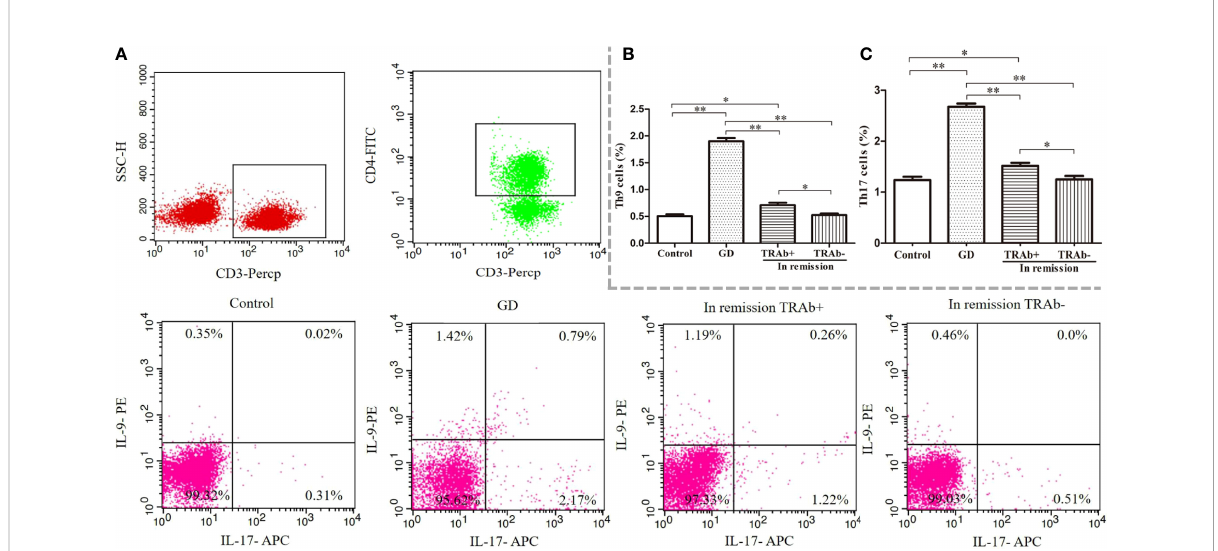
FIGURE 2 Flow cytometry analysis of Th9 and Th17 cells in patients with Graves ’ disease (GD) at different stages. Gating of CD4 + T cell populations and intracellular cytokine staining of Th9 and Th17 cells is represented using fl ow cytometry for each group (A) . The sum of the numbers in the upper left and upper right quadrants, and the upper right and lower right quadrants is the percentage of Th9 and Th17 cell subsets in the gated CD4 + T cell population, respectively. Statistical analysis of Th9 and Th17 cell frequencies in the four groups is shown (B, C) . * P < 0.05, ** P < 0.01. TRAb, thyroid-stimulating hormone receptor antibody.